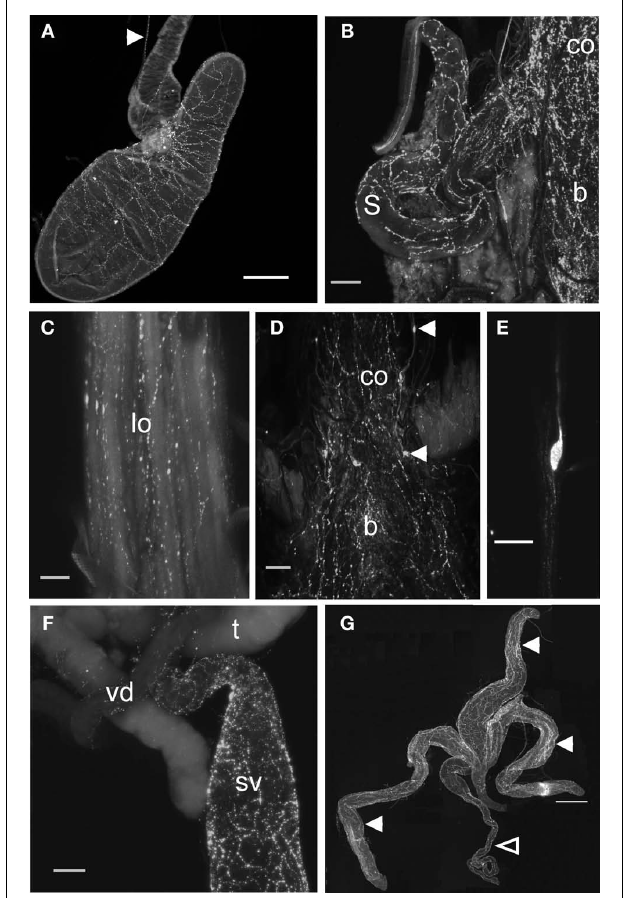
FIGURE 6 | Proctolin-like immunoreactivity is associated with digestive and reproductive tissues of R. prolixus . (A) Proctolin-like immunoreactivity is present (arrowhead) in axons in the nerve projecting to the principal and accessory salivary gland and proctolin immunoreactive processes are associated with the salivary gland of fifth instar R. prolixus. (B–E) Proctolin-like immunoreactive processes are associated with the common oviducts (co), lateral oviducts (lo), bursa (b), and spermatheca (s) in adult female R. prolixus , with a series of immunoreactive bipolar neurons [arrowheads, (D) ] localized over the common oviduct and bursa (D,E) . (F,G) In adult males, proctolin-like immunoreactive processes are associated with the seminal vesicles (sv) and vas deferens (vd) (F) , and over the transparent (closed arrowheads) and opaque accessory glands (open arrowhead) (G) . No immunoreactivity was associated with the testis (t). Scale bars: A = 200 μ m; B, D, F = 100 μ m; C = 50 μ m; E = 20 μ m; G = 500 μ m, n =